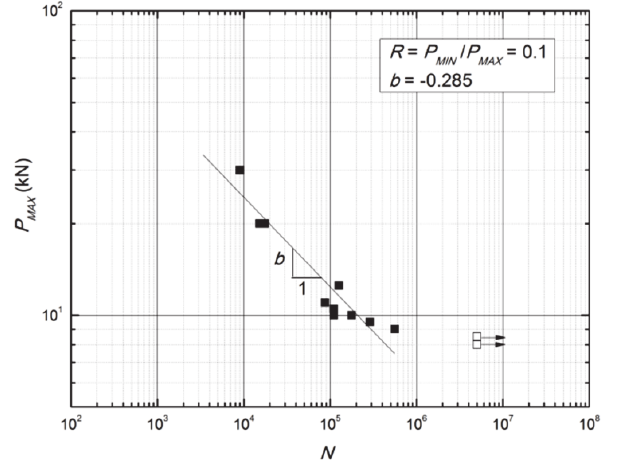
Figure 15: P max – N